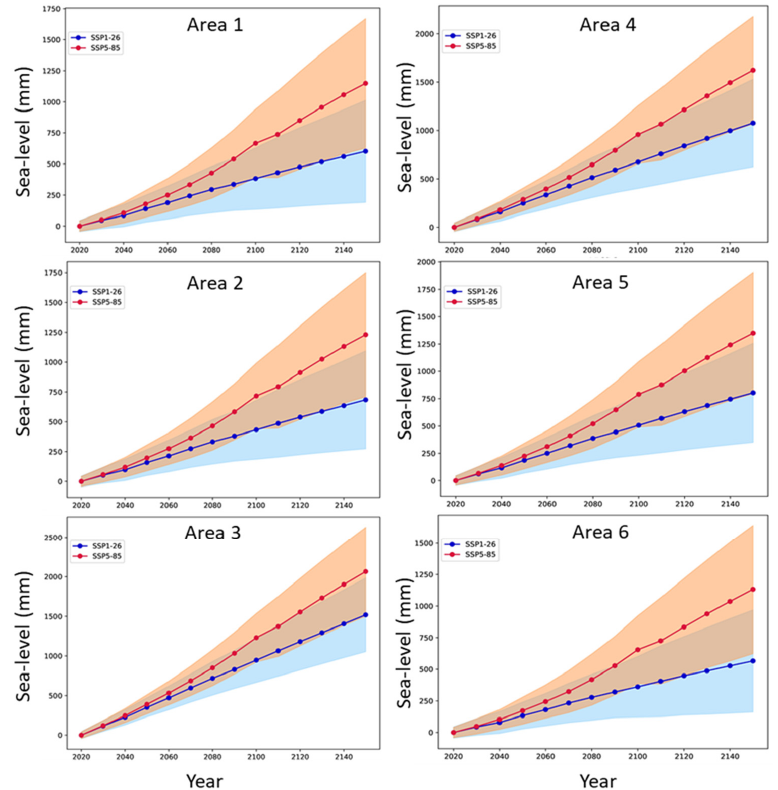
Figure 5. SLR projections estimated at the upper 95% bounds of the regional IPCC, integrated with the contribution of the mean Vertical Land Movement (VLM) rate derived from the InSAR data and long-term geological elevation of the MIS 5.5 marine terrace, relative to 2019 AD. Blue and red curves refer to the SSP1-2.6 and SSP5-8.5 climate scenarios, respectively.